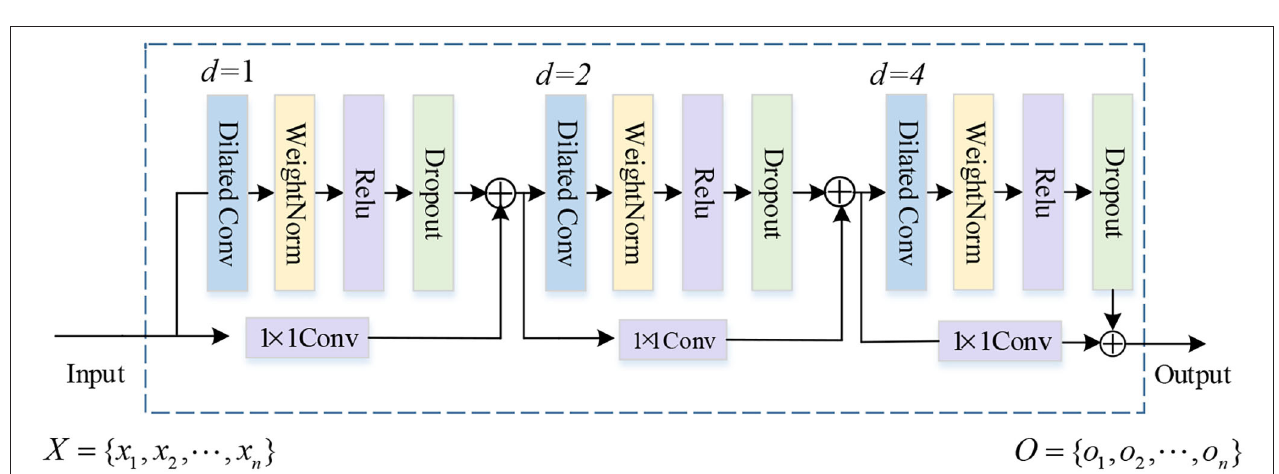
FIGURE 3 | The structure of MDiconv. The dilation factors d = 1, 2, and 4, and filter size k = 3.